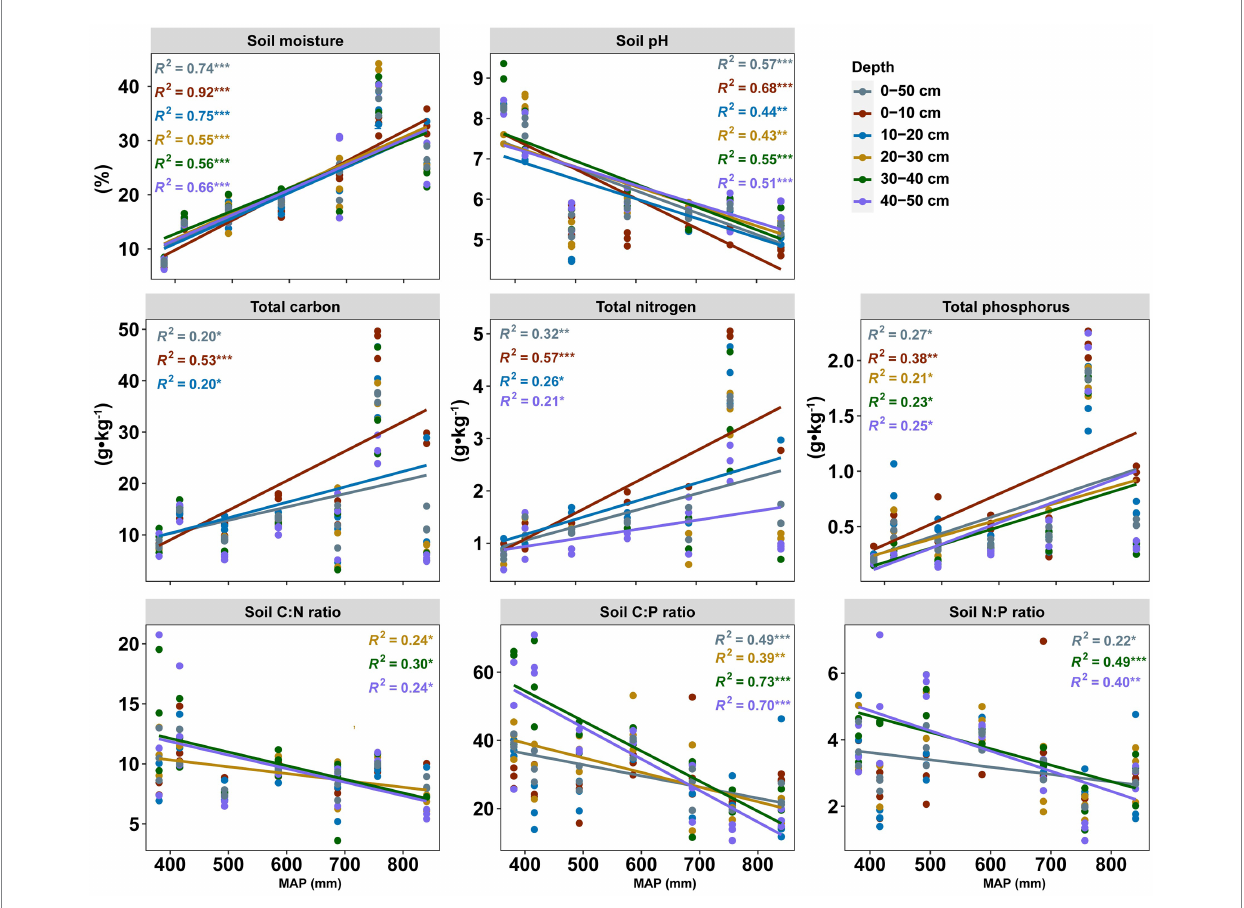
FIGURE 1 Linear regression between soil properties and MAP for each soil layer. Colored lines represent the regression of each soil layer ( n = 105). Statistics ( R 2 and p values) for the regression are indicated using the corresponding colored text: *** p < 0.001, ** p < 0.01, and * p < 0.05. Only significant differences are shown.